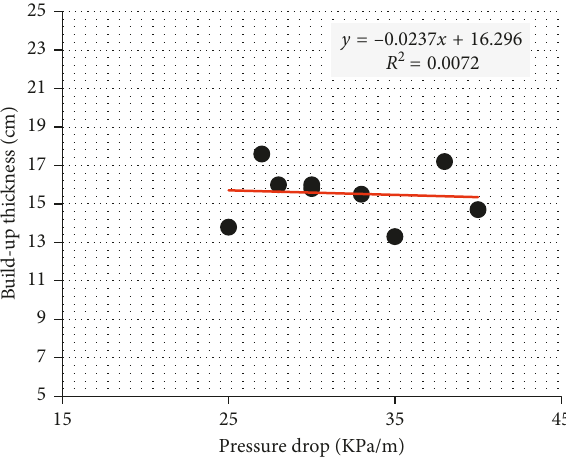
Figure 17: Correlation between pumpability and shootability.